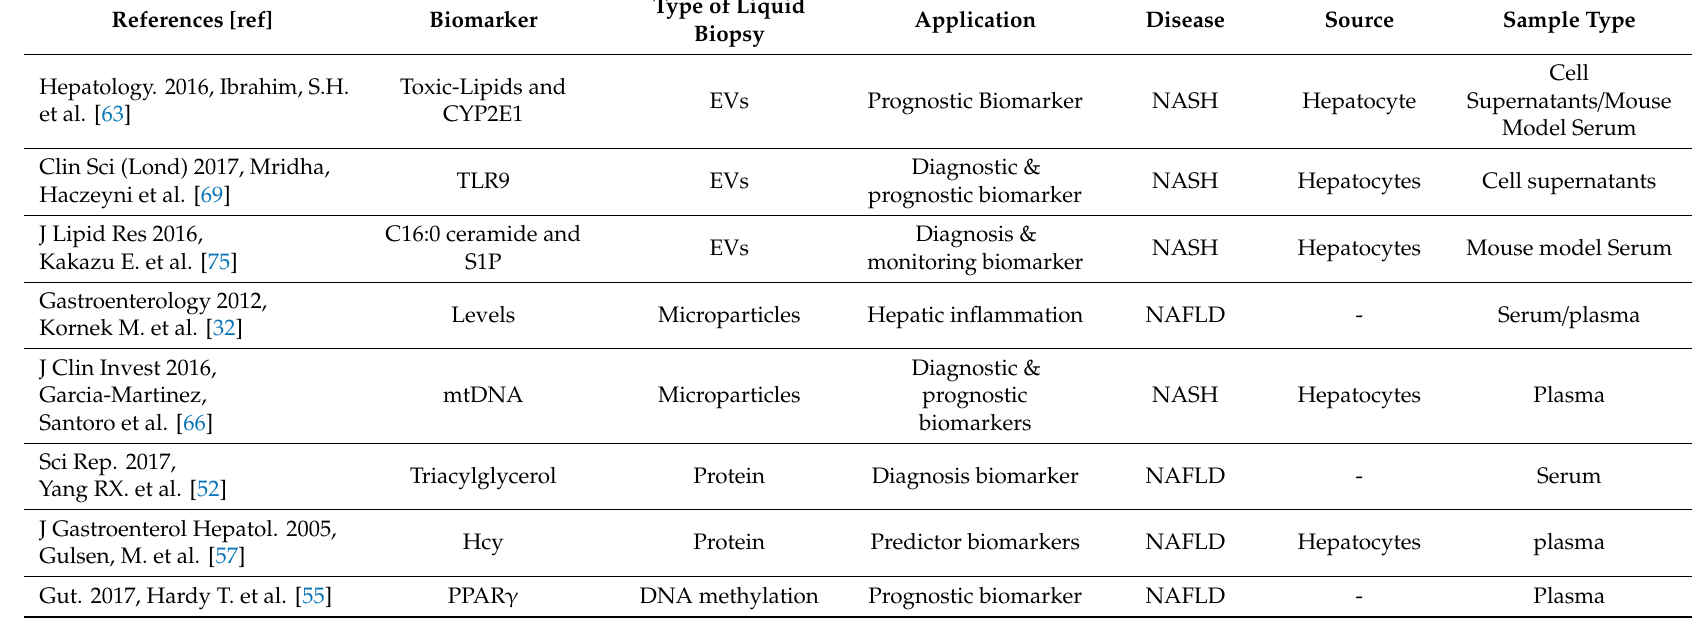
Table 2. Liquid biomarkers of NASH